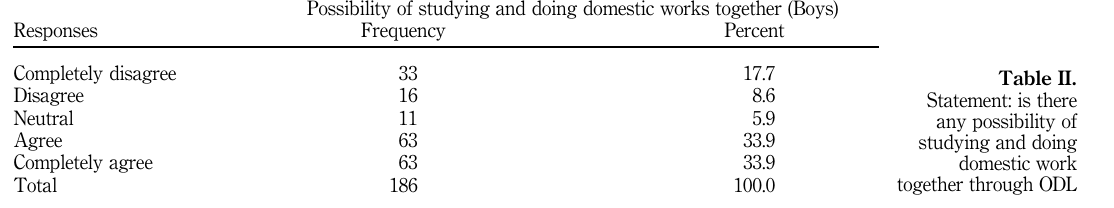
Table II. Statement: is